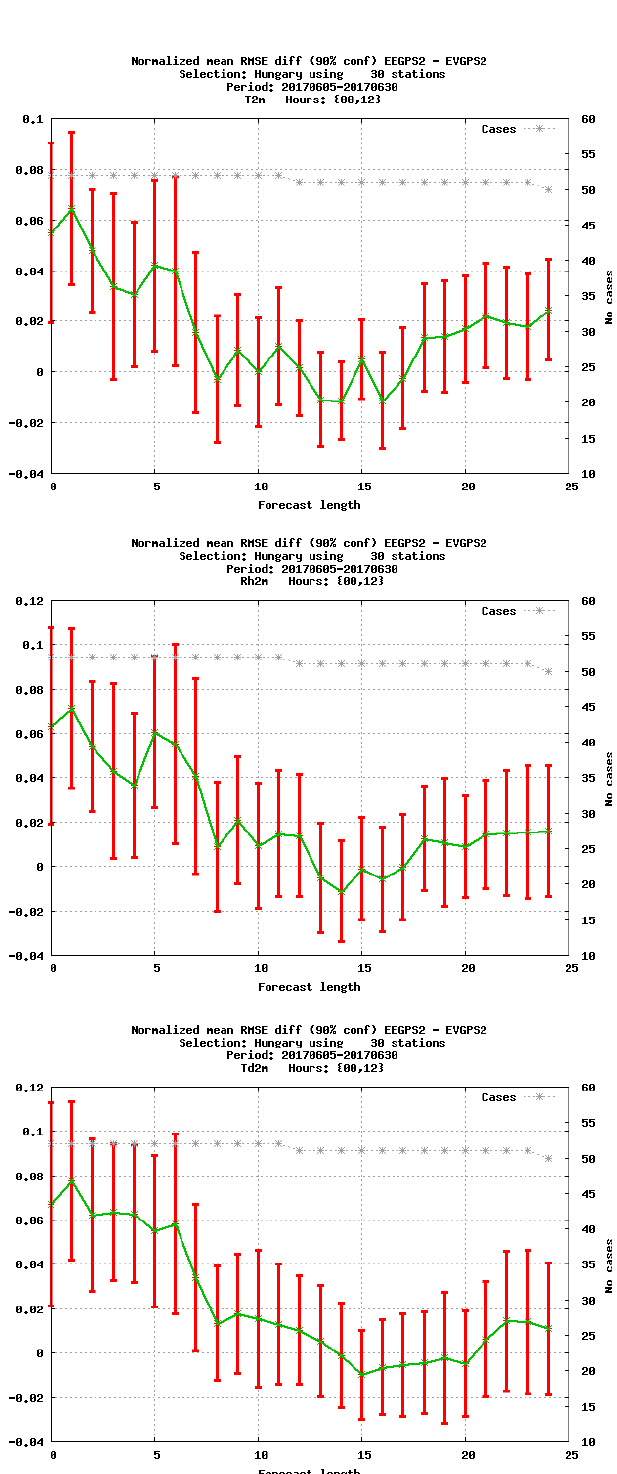
Figure 9. The normalised RMSE difference of screen-level tem- perature ( ◦ C), relative humidity (%), and dew-point tempera- ture ( ◦ C) as a function of forecast range. Scores are comparing EEGPS2 and EVGPS2 experiment. Verification period between 5 and 30 June 2017. Data selection: Hungary, 30 stations.